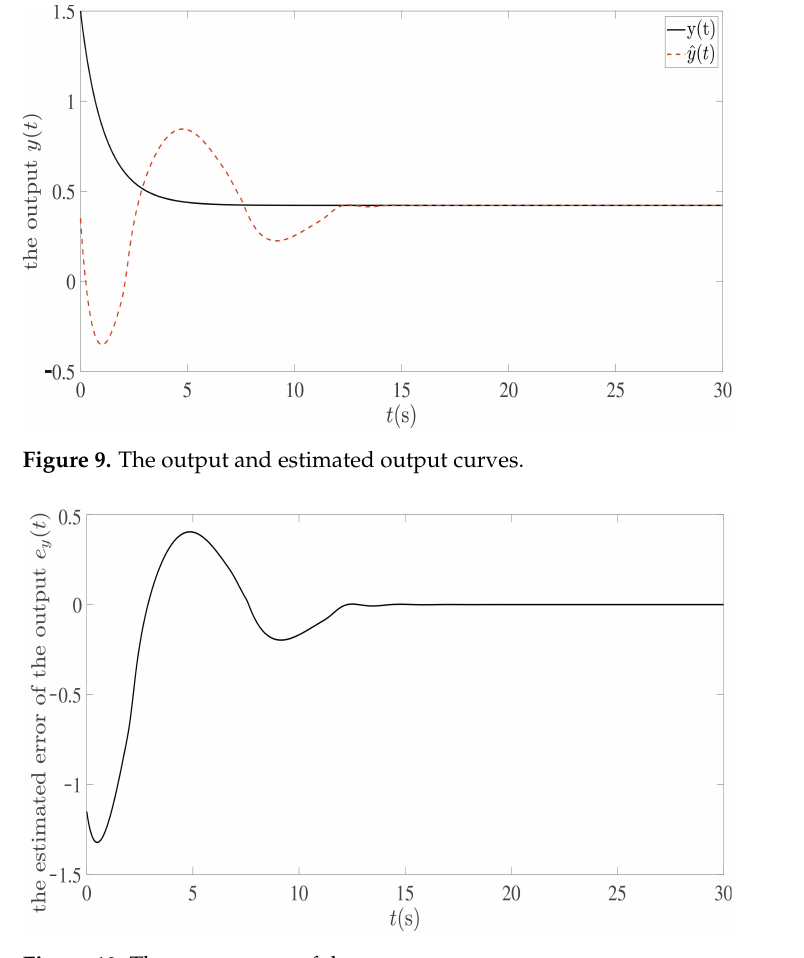
Figure 10. The error curves of the output.